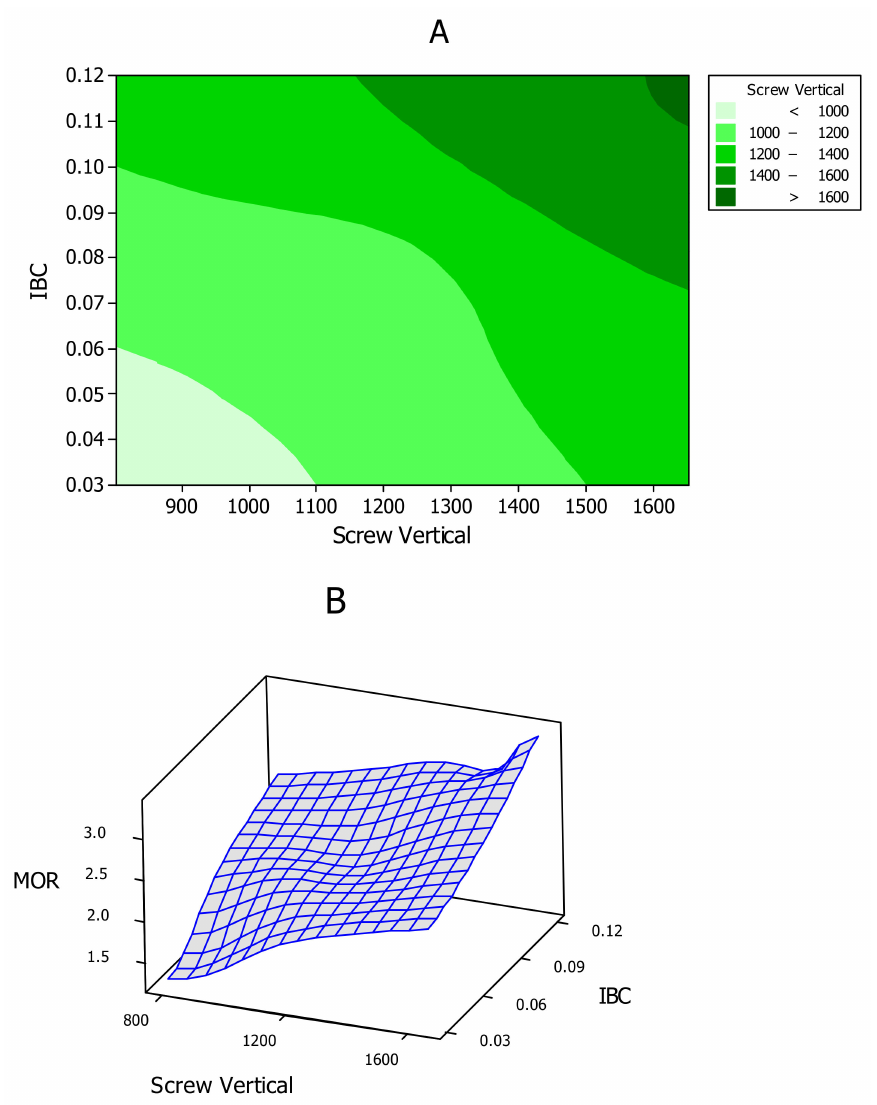
Figure 5. Contour ( A ) and surface ( B ) plots, based on mechanical properties of the four board types. The thickness swell values after 24 h immersion in water are summarised in Table